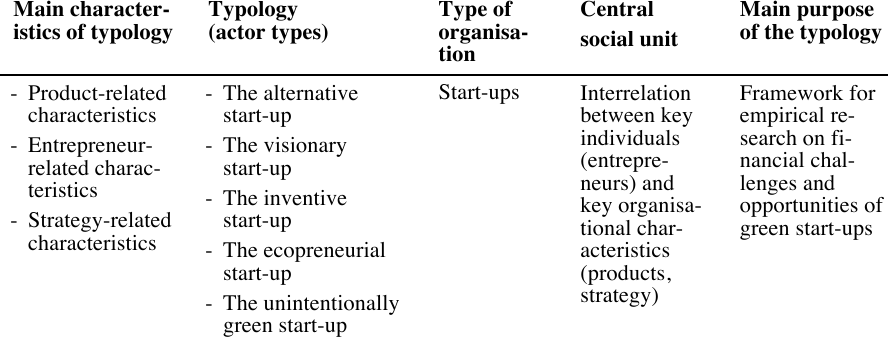
Table 3. Characteristics of the elaborated typology of green start-ups Main character- istics of typology